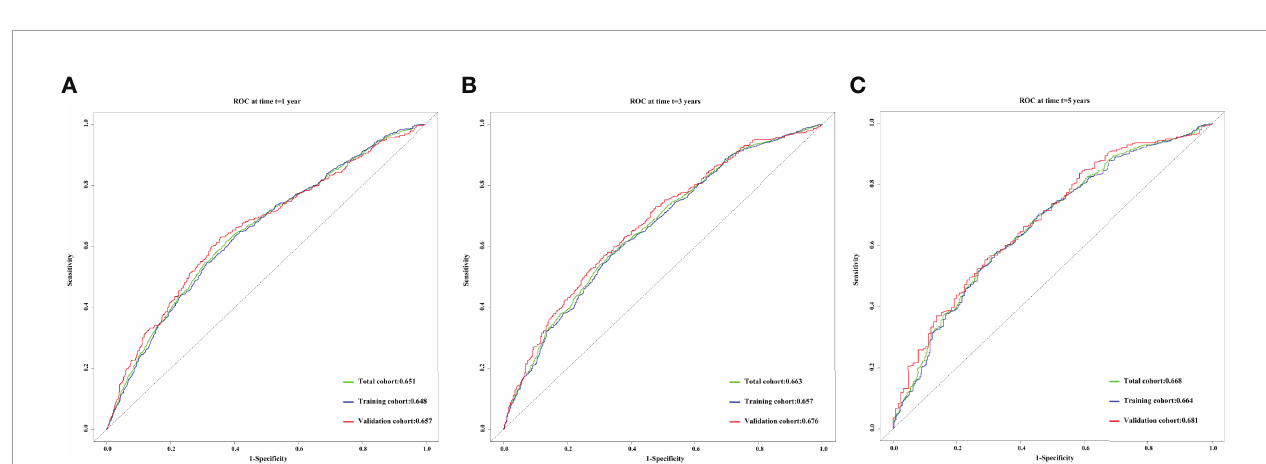
FIGURE 2 | The 1-, 3-, and 5-year prognostic ROC curves of CTI in the different cohorts of patients with cancer. (A) 1- year prognostic ROC curve; (B) 3- year prognostic ROC curve; (C) 5- year prognostic ROC curve. Green line, total cohort; Blue line, training cohort; Red line, validation cohort. CTI, C-reactive protein- triglyceride glucose index; ROC, receiver operating